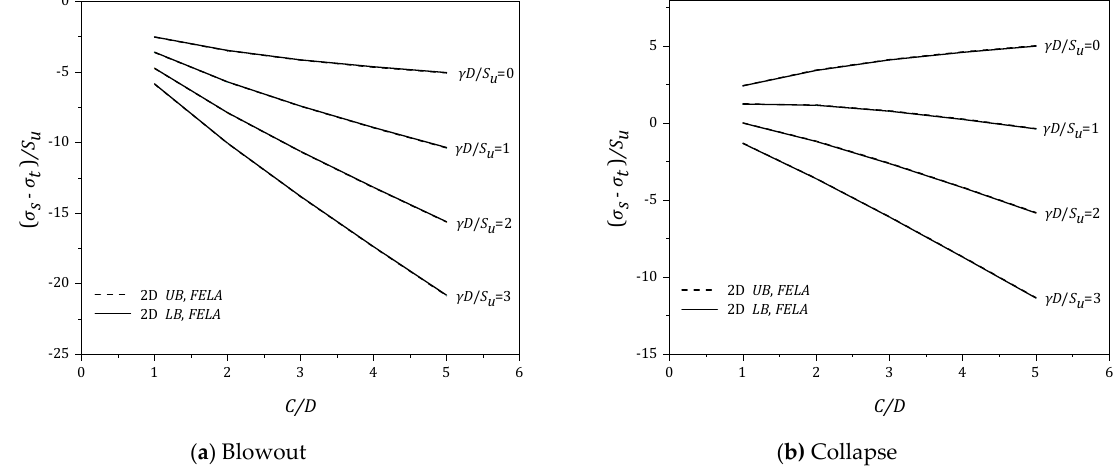
( b ) Collapse Figure 11. ( σ s − σ t )/ S u vs ( C/D ) for various ( γ D/S u ) − B/D = 1.33.